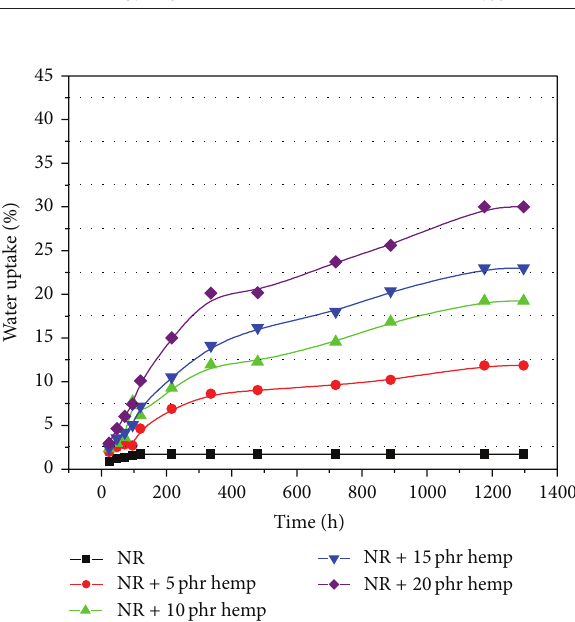
Figure 7: Water uptake of polymeric composites at absorbed dose of 75 kGy.